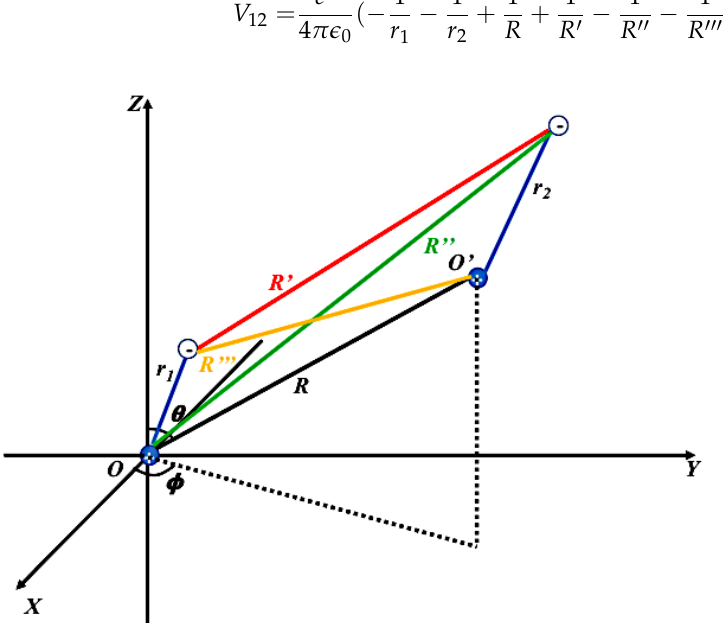
Figure 1. Two ion cores are locatedat O and O (cid:48) . The electron of the bottom atom is r 1 (the bottom blue line) away from the bottom ion core, and the electron of the top atom is r 2 (the top blue line) away from the top ion core. R is the distance between the two ion cores. R (cid:48) (—) is the distance between the two electrons. R (cid:48)(cid:48) (—) is the distance between the bottom ion core and the electron of the top atom. R (cid:48)(cid:48)(cid:48) (—) is the distance between the electron of the bottom atom and the ion core of the top